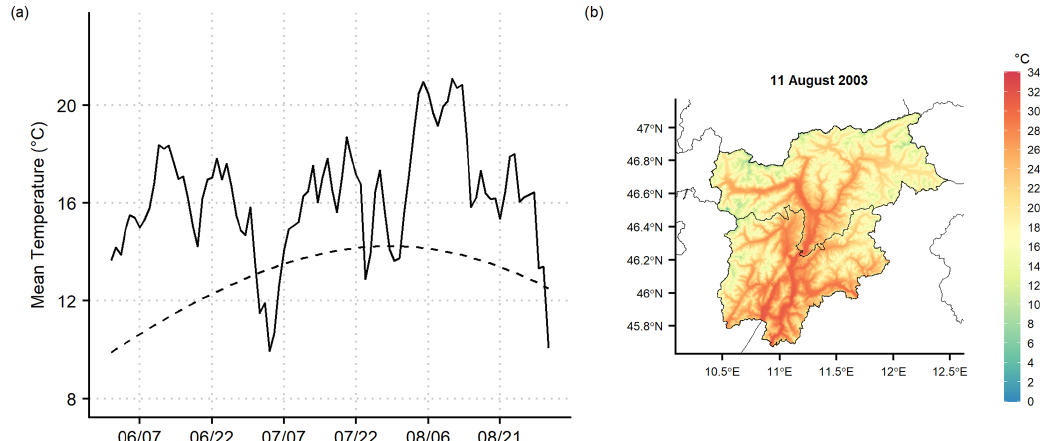
Figure 12. In panel (a) the regional daily mean temperature series for summer 2003 is shown (solid line), together with the 1981–2010 daily normals (dashed line); in panel (b) the spatial distribution over Trentino-South Tyrol of mean temperature on the hottest summer day in 2003 (11 August) is reported at 250m grid